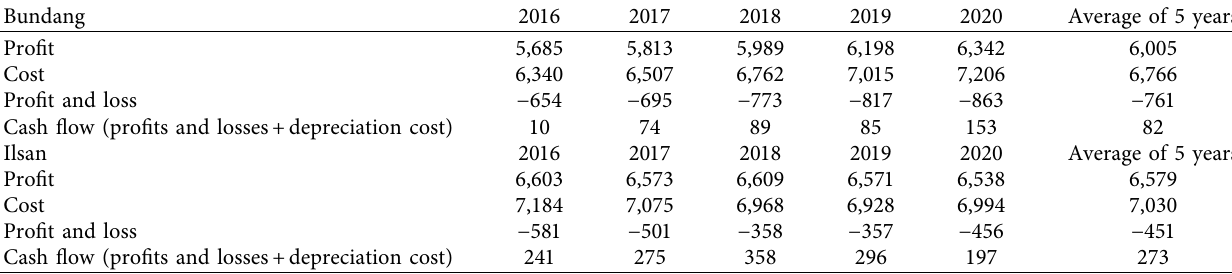
Table 1: Cash flow performance of public sports center in Bundang and Ilsan (unit: KRW 1 million). Bundang